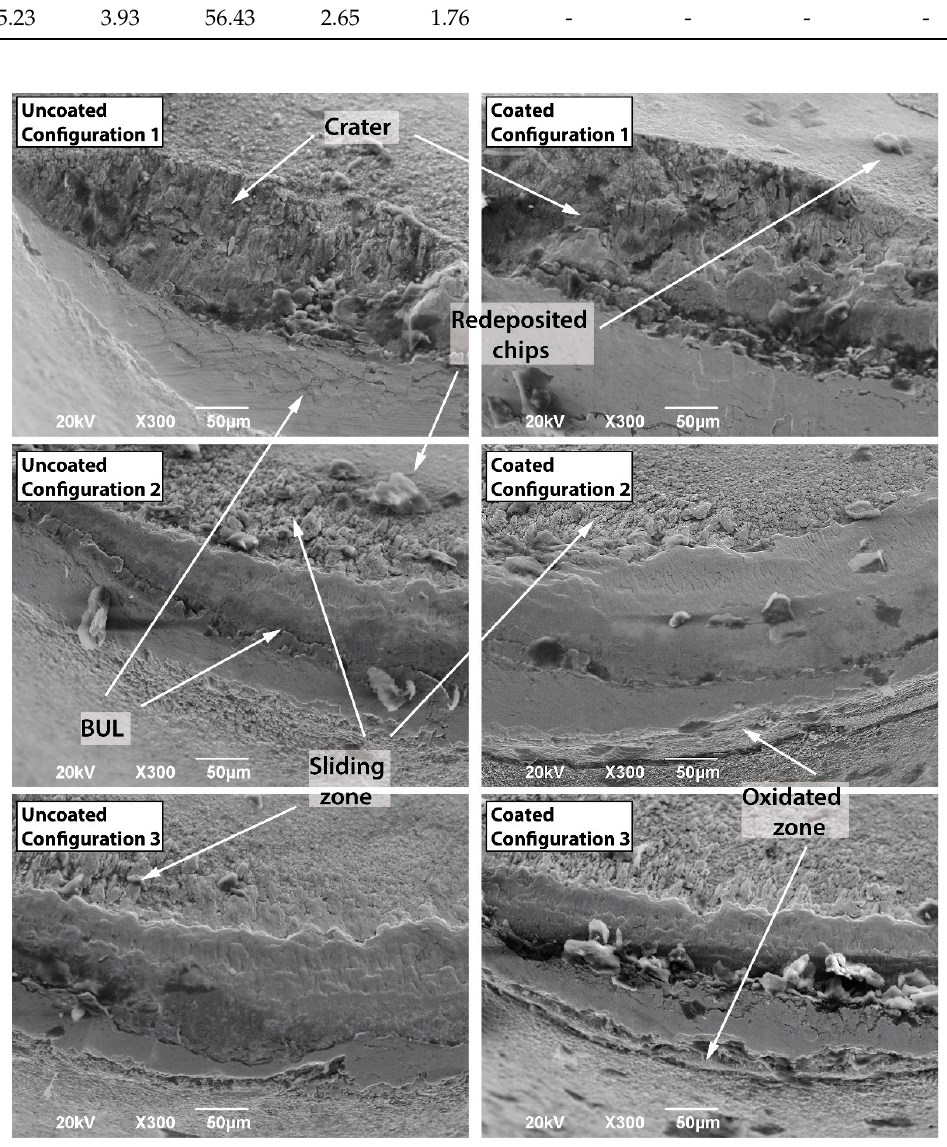
Figure 7. Detail of the wear mechanisms for the experimented coated and uncoated tool after ma- chining at a cutting speed of 50